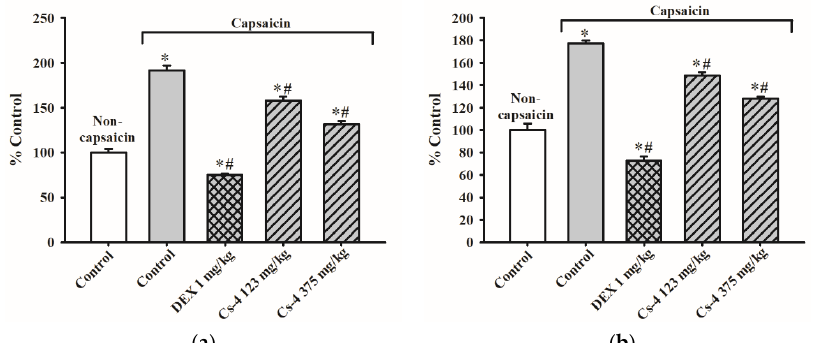
Figure 9. The effect of Cs-4 on the ( a ) IgE level and ( b ) eosinophil peroxidase (EPO) level in the bronchoalveolar (BAL) fluid of capsaicin-challenged rats. Data were expressed as the control percent of noncapsaicin rats, with the control value being (a) 13.3 ± 0.58 ng/mL IgE and (b) 0.600 ± 0.034 ng/mL EPO. Each bar represents the mean ± S.E.M., with n = 8. * Significantly different from the noncapsaicin control group. # Significantly different from the capsaicin control group.